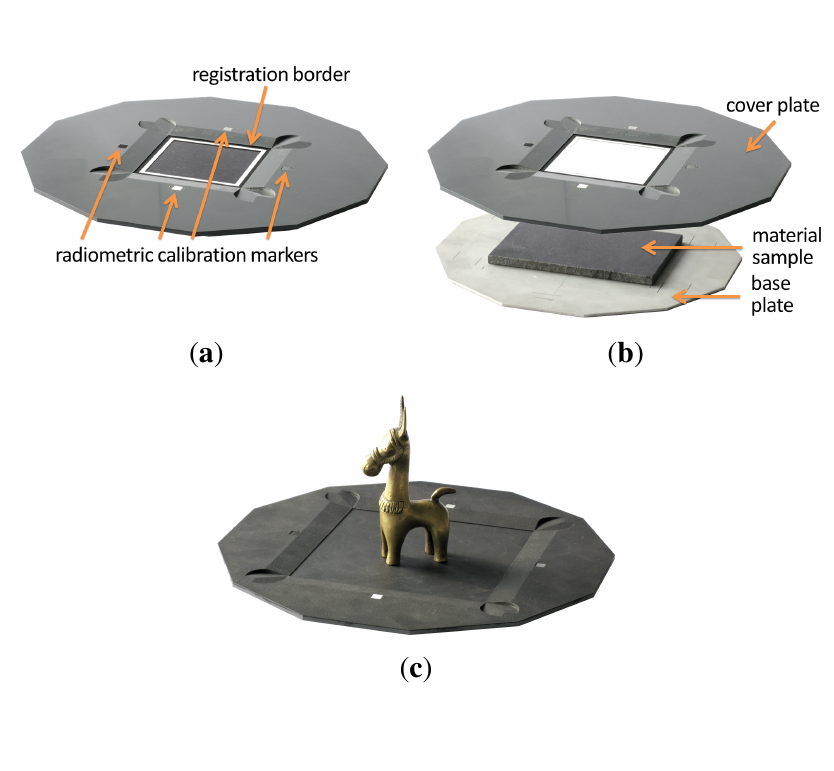
The sampleholder design employed in the Dome 1 setup. ( a ) for materials; ( b ) individual parts; ( c ) for